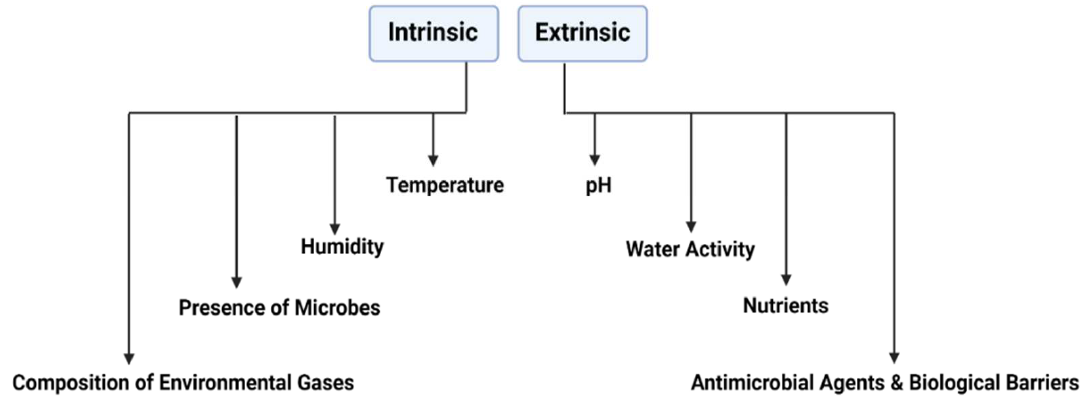
Figure 3. Factors affecting the efficacy of S. cerevisiae var boulardii .